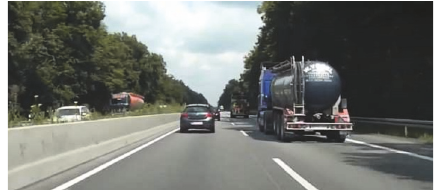
Figure 1: Picture following description of scenario 1.